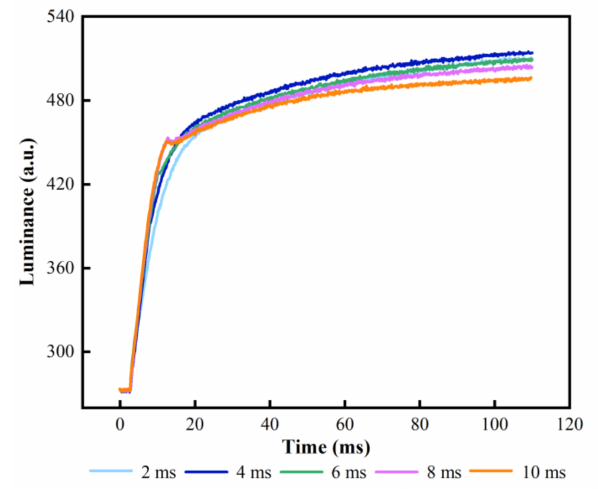
Figure 8. Luminance curves of different t 1 s. Luminance is proportional to the duration of the overdriving voltage in the driving stage. The highest luminance was 514 when t 1 was 4 ms. In addition, the influence of the DC voltage and the driving time were analyzed, respectively. The selection range of V p and t 2 were 22–30 V and 0–120 ms,